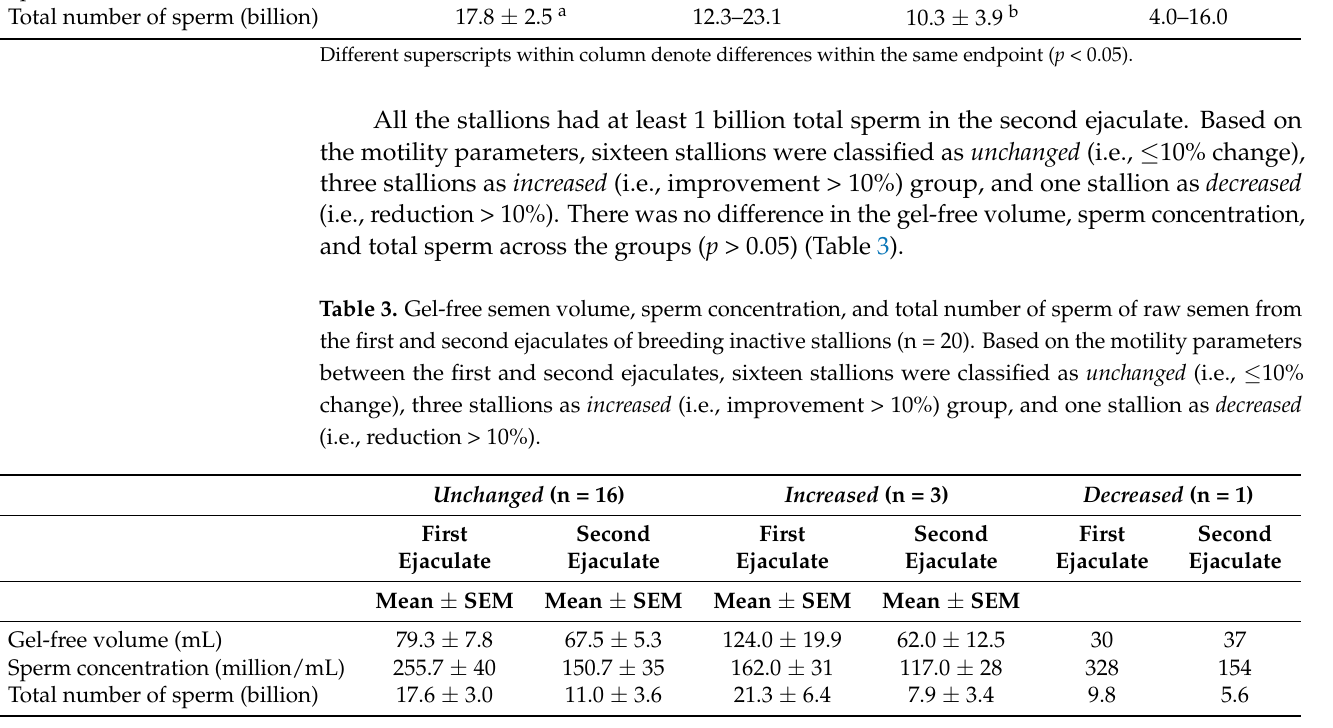
Table 2. Gel-free semen volume, sperm concentration, and total number of sperm of raw semen from the first (n = 20) and second ejaculates (n = 20) of breeding inactive stallions (n = 20). First Ejaculate Second Ejaculate Mean ± SEM CI-95% Mean ± SEM CI-95% 83.5 ± 8.1 a